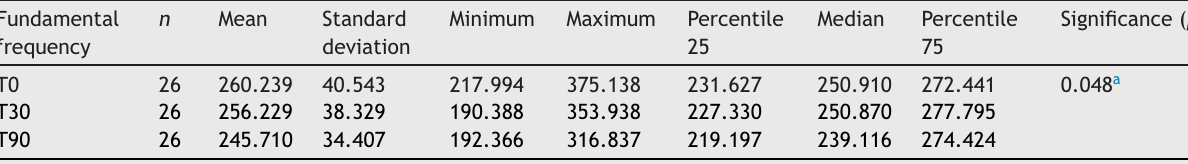
Fundamental frequency --- Vowel /i/. Fundamental